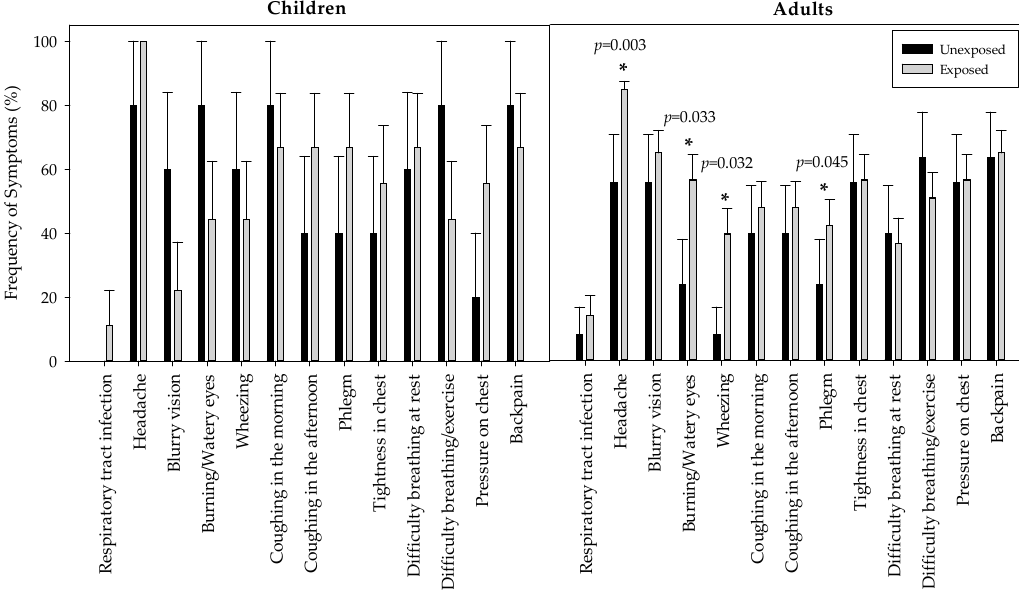
Figure 2. Reported respiratory and non-respiratory symptoms in children and adults. Unexposed adults did not have any reported exposure to HAP, and experienced significantly less headaches, burning and watering eyes, phlegm production and wheezing than adults who reported as being exposed to one or more HAP sources ( p < 0.05). There were no significant differences between reported respiratory and non-respiratory symptoms in exposed adults and children ( p > 0.05). Errors bars represent SD in sample population.